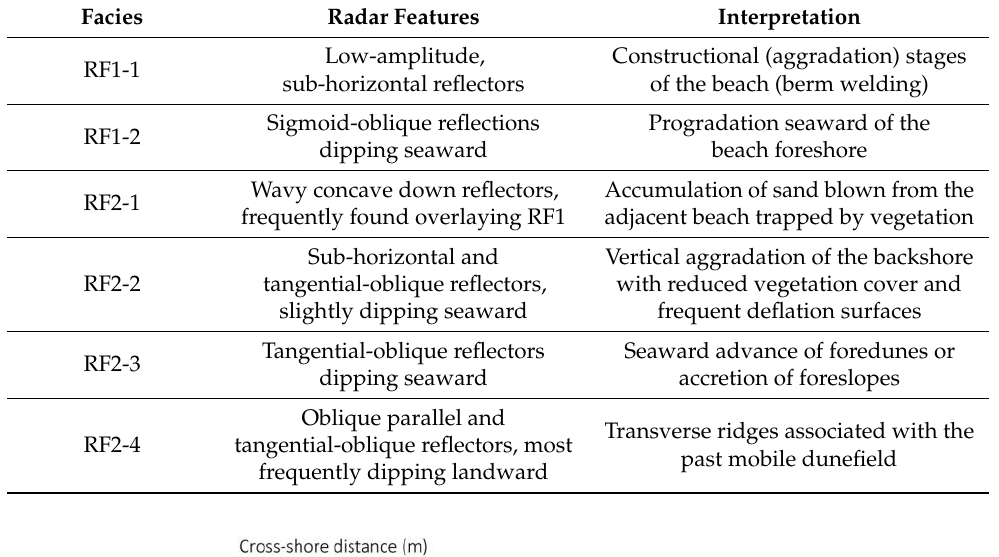
Table 1. Facies associations and characterisation of identified radar facies.